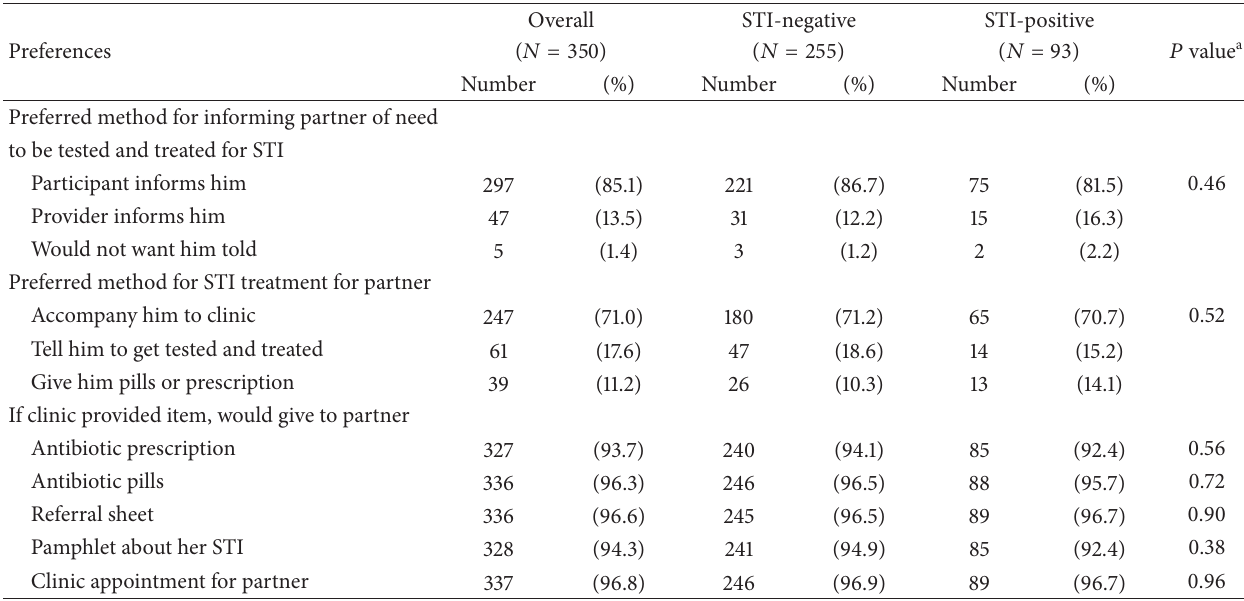
Table 2: Baseline participant preferences for partner notification, overall and by sexually transmitted infection status at baseline.